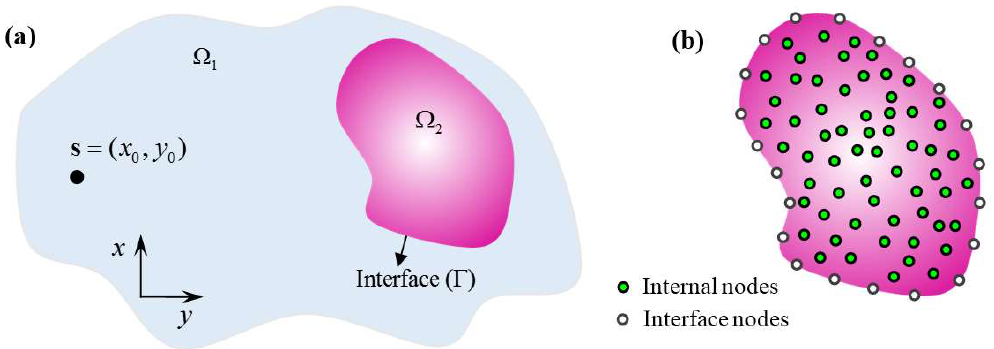
Figure 1. Schematic diagrams of ( a ) acoustic wave propagation in heterogeneous media and ( b ) nodal distribution for the coupled method.